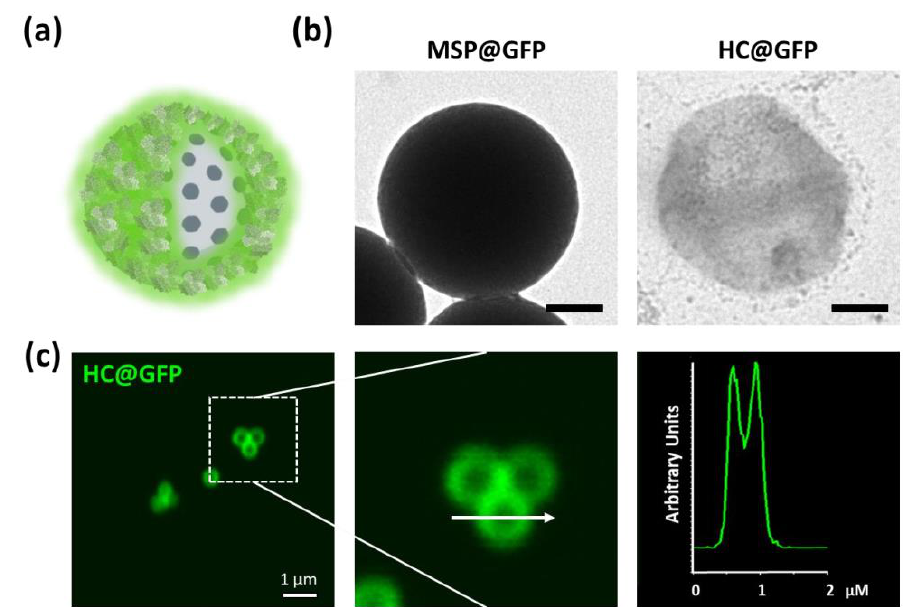
Figure 3. Fluorescent protein nanocapsules. ( a ) Schematic representation of green fluorescence protein (GFP) coated MSPs. ( b ) TEM images of GFP-coated MSPs before (left) and after silica dissolution (right). Resulting HC@GFP capsules after protein crosslinking and MSP core dissolution. ( c ) Confocal microscopy single plane image of the fluorescent HC@GFP nanocapsules. (right) Fluorescent protein profile obtained of one of the capsules (arrow) where a central cavity devoid of protein (empty core) can be identified. Scale bar corresponds to 100 nm.